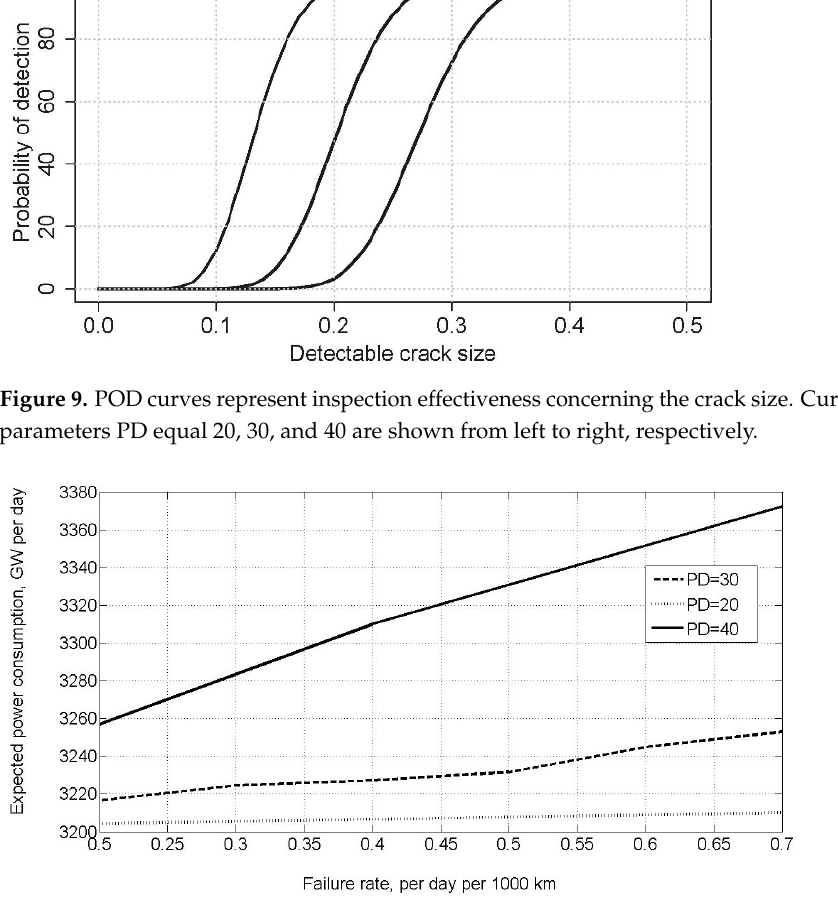
Figure 9. POD curves represent inspection effectiveness concerning the crack size. Curves with shape parameters PD equal 20, 30, and 40 are shown from left to right, respectively.